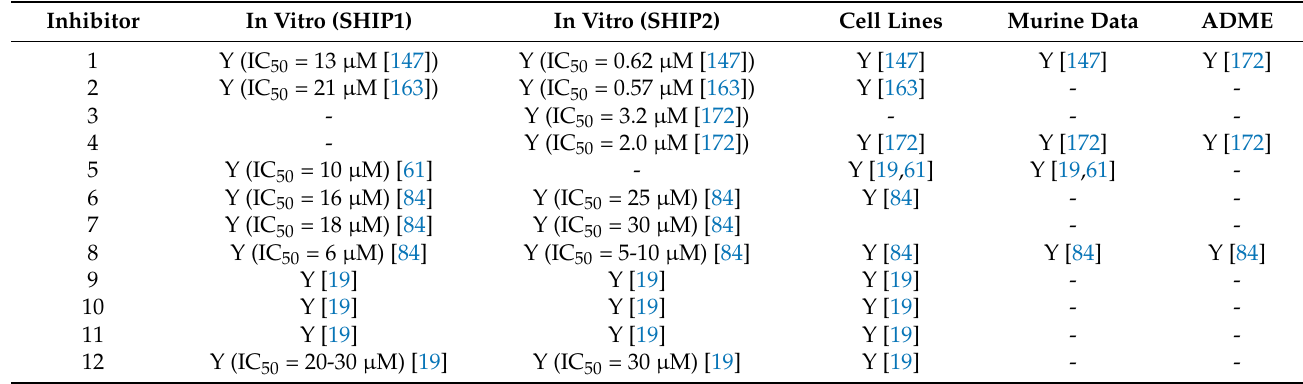
Table 1. Summary of SHIP